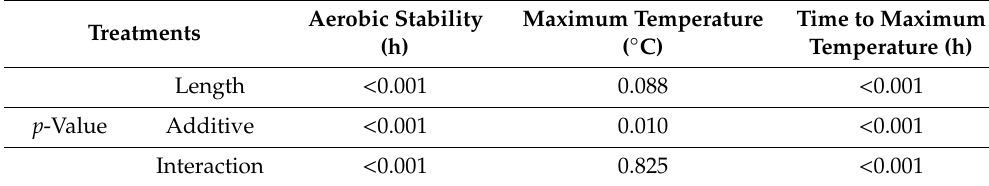
Table 4. Significant analyzes of length, additive, and their interactions on aerobic stability, maximum temperature and the time to maximum temperature of L. chinensis silage.